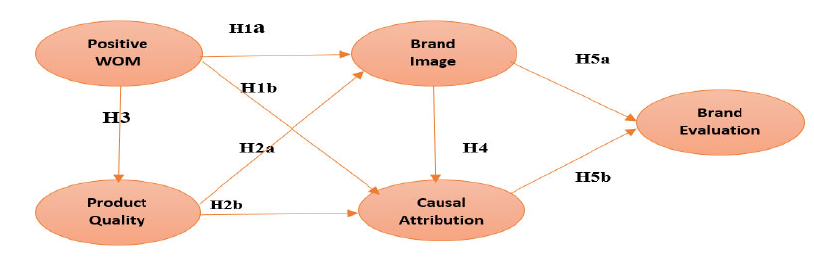
Fig. 1. Conceptual Model (Item Response